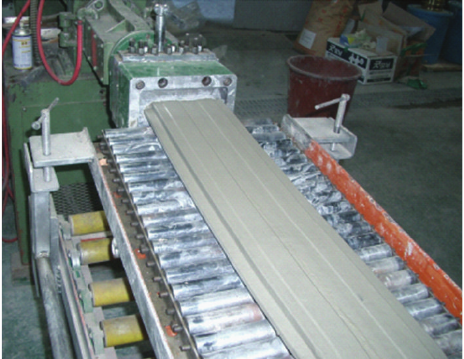
Figure 2: Extruding process of DFRCC panel.